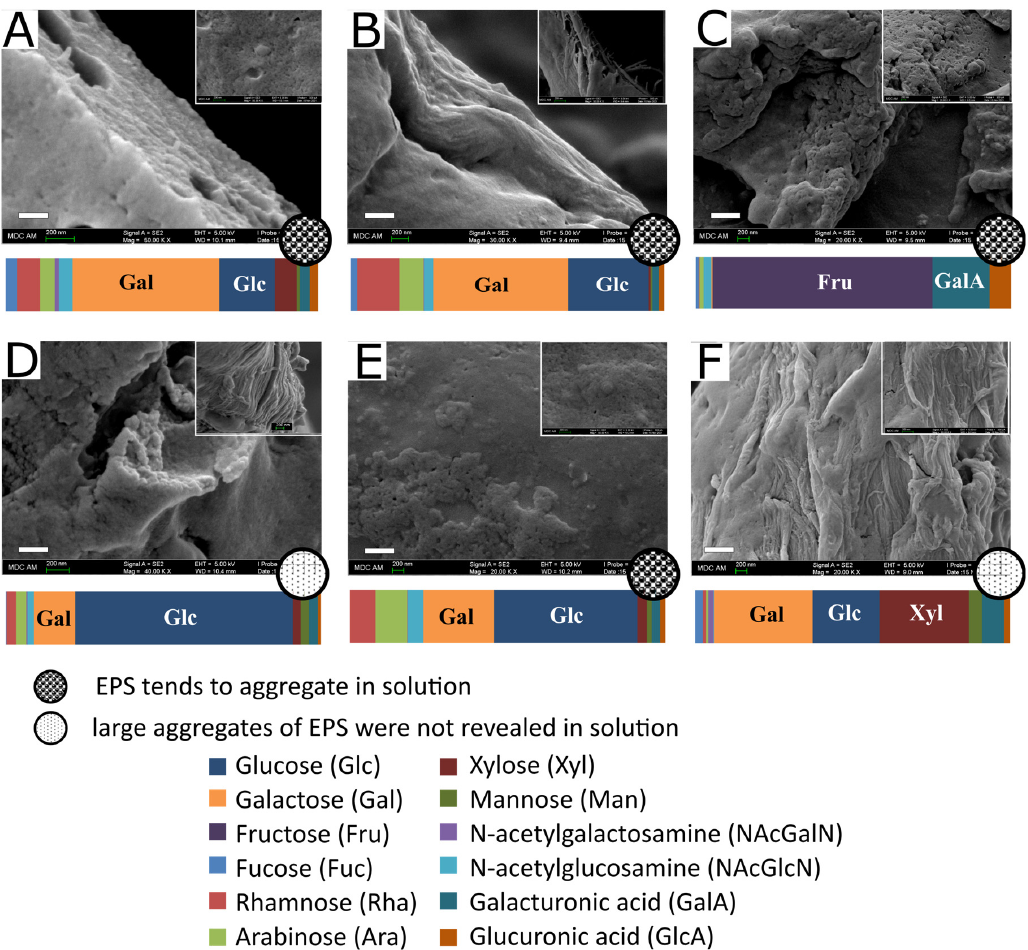
Figure 4. Scanning electron microscopy of EPS isolated from skim milk fermented by different strains of LAB (( A ) L. bulgaricus , ( B ) L. plantarum AG1, ( C ) L. fermentum AG8, ( D ) L. plantarum AG9, ( E ) L. plantarum AG10, ( F ) L. rhamnosus AG16).